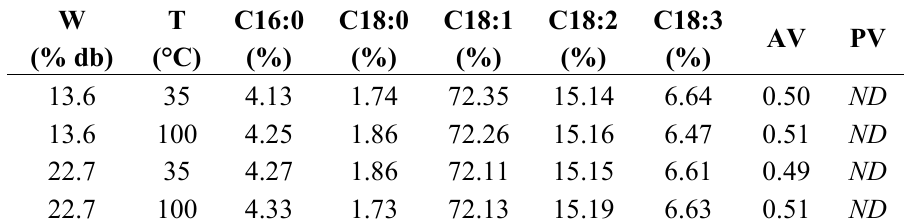
Table 2. Characteristics of canola oil extracted after the drying pretreatment of seeds at different initial moisture contents (W) and drying temperatures (T) and final moisture content of 7%